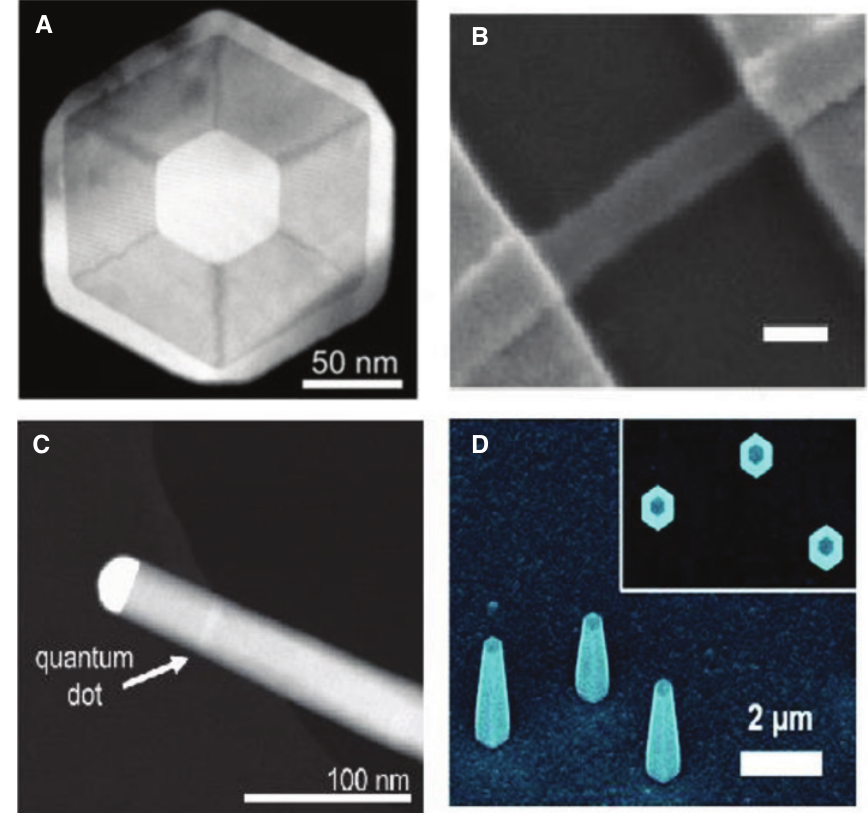
Figure 7: Different types of semiconductor NW: (A) GaAs/AlGaAs (core-shell) [104], (B) MSM based on CdS nanowire [105], (C) high- resolution TEM image of an InP nanowire with an embedded InAsP quantum dot [106] and (D) GaAs-based avalanche photodiode (APD) nanoneedles